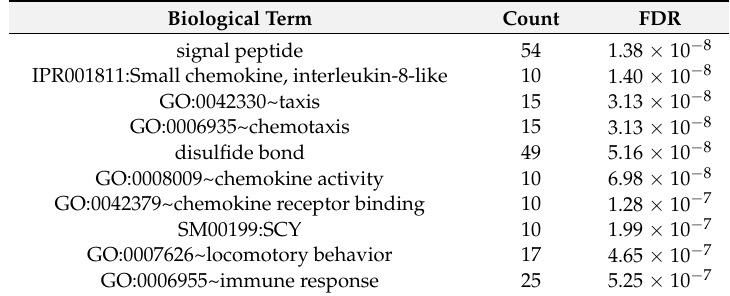
Table 4. FDR-ranked top 10 biological terms significantly enriched in the set of 142 DE-genes when comparing the expression profile for 499 genes between EBV+ and EBV − GC cases. Biological Term Count